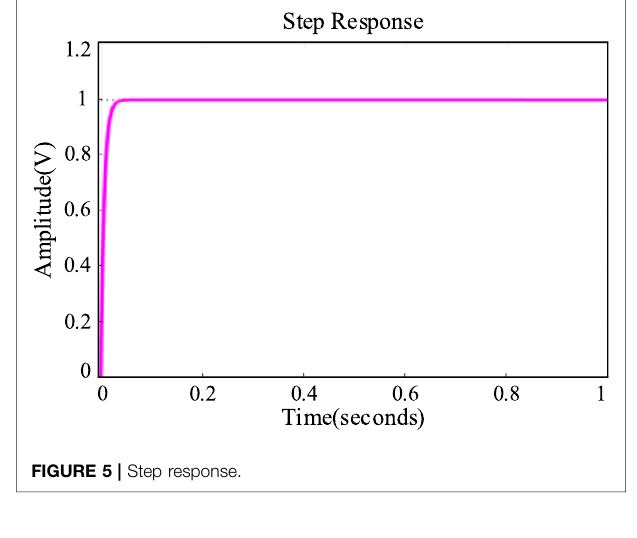
FIGURE 5 | Step response.